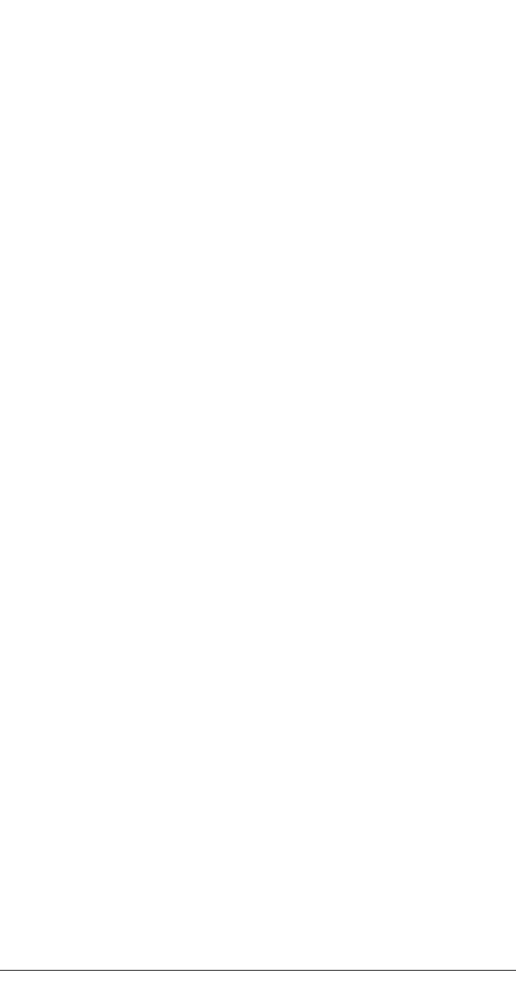
Figure 3 Algorithm 2: algorithm for identifying the time-varying